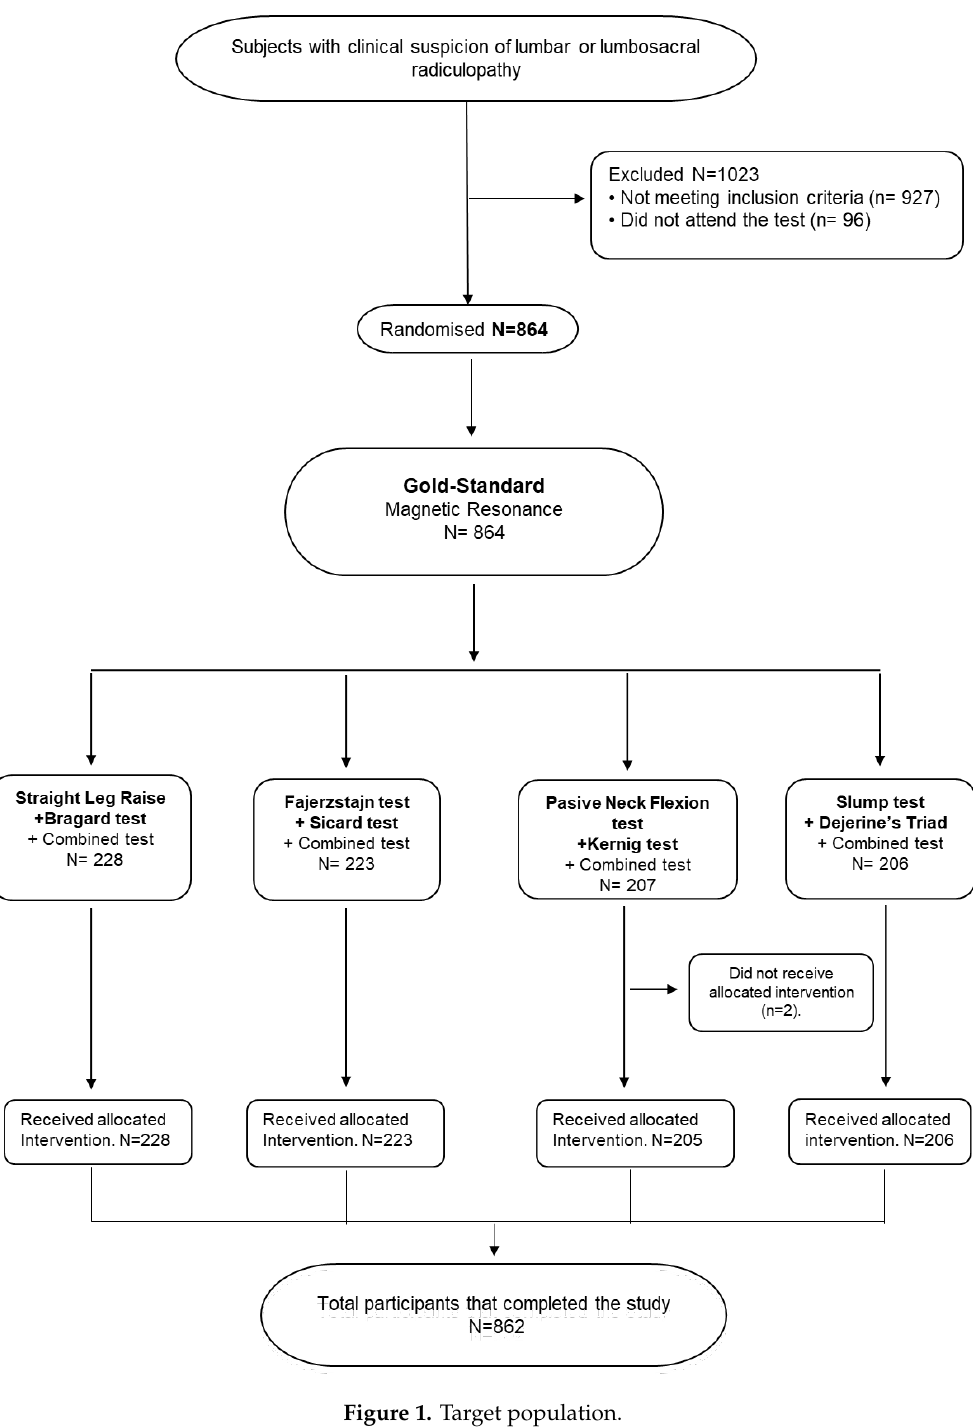
Figure 1. Target population.